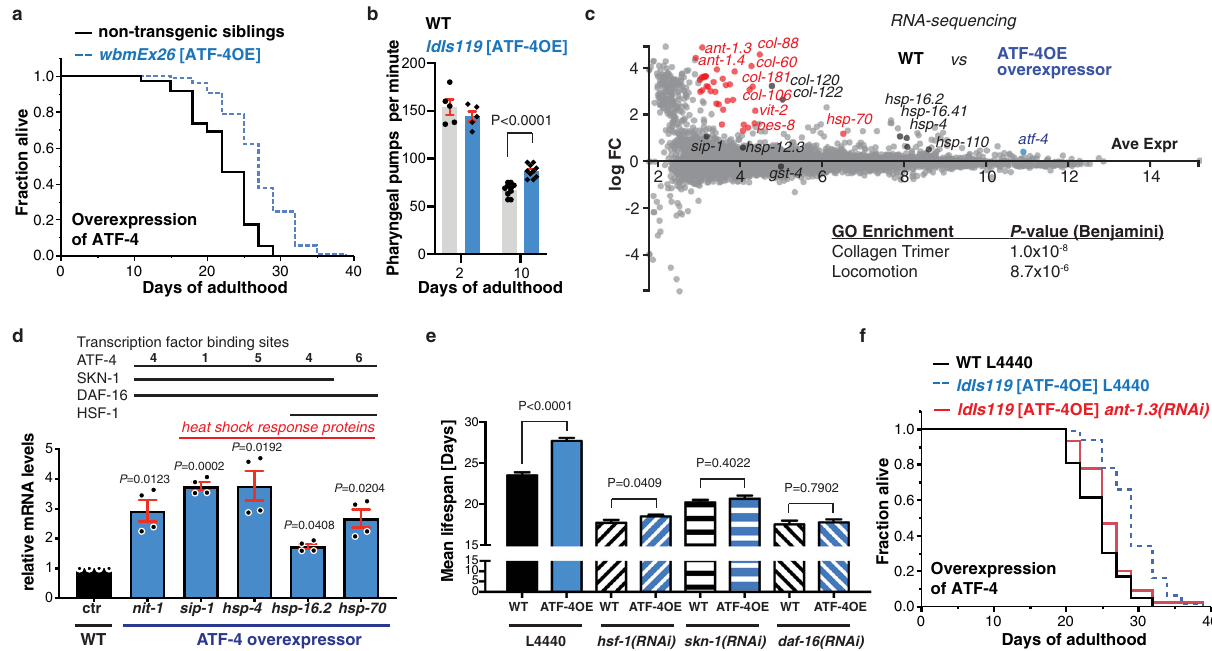
Fig. 3 ATF-4 overexpression is suf fi cient to increase lifespan. a Transgenic animals ( wbmEx26 [P atf-4 ::ATF-4(gDNA)::GFP]) that overexpress ATF-4 (ATF-4OE) live longer compared to their non-transgenic siblings. b Pharyngeal pumping rate is similar at day 2 of adulthood between ATF-4OE ( ldIs119 [P atf-4 ::ATF-4(gDNA)::GFP]) and WT, but higher in ATF-4OE at day 10 of adulthood, suggesting an improved healthspan. For the complete time-course of pharyngeal pumping rate during ageing, see Supplementary Data 2. Mean ± SEM. At least 5 worms were examined for each genotype and time point in one experiment. Unpaired two-tailed t -test. c MA (log ratio and mean average)-plot of RNA sequencing analysis comparing ATF-4OE( ldIs119 ) to WT, showing absolute log fold change (FC). In red, highlighted genes with FDR < 0.1 and log FC > 1 compared to WT. In black, genes with FDR > 0.1. Details are in Supplementary Data 3. d Validation by qRT-PCR of genes differentially expressed in ATF-4OE( ldIs119 ), using two new independent biological samples of about 200-215 animals each measured in duplicates. Mean ± SEM. P values relative to WT determined by one sample t -test, two-tailed, hypothetical mean of 1. The numbers of ATF4 binding sequences (-TGATG-) 27,28 are indicated in Supplementary Data 4. The DAF-16 and SKN-1 transcription factor binding sites are based on ChIP data from www.modencode.org (Supplementary Data 5). e Longevity conferred by ATF-4OE( ldIs119 ) is abolished by knockdown of hsf-1, skn-1, or daf-16 . Mean± SEM of Kaplan – Meier survival plot. P -value determined by log-rank. n = 1 biological replicate. f The mitochondrial ATP translocase ant-1.3 is required for ATF-4 overexpression induced longevity. For statistical details and additional lifespan trials in ( a ), ( e ), and ( f ), see Supplementary Data (Fig. 3c) 26 . The 3 kb predicted promoter regions of many ATF-4-